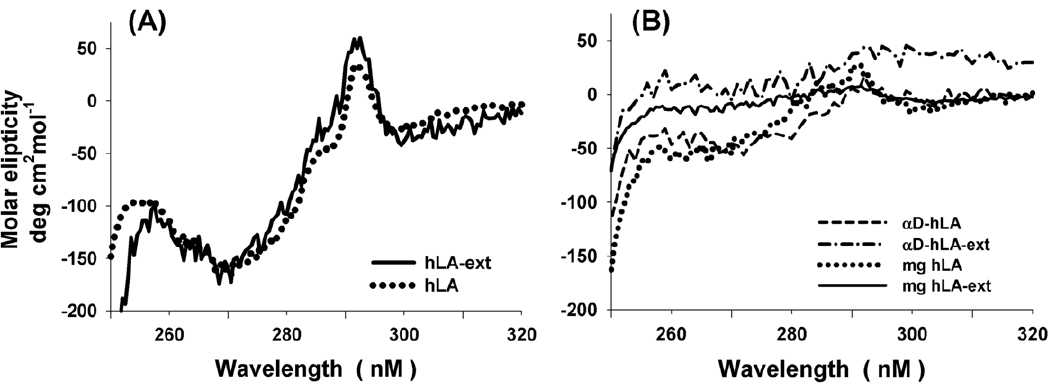
Figure 2. Tertiary structure studied with near UV CD spectra. (A) The near UV spectra of the native refolded hLA and hLA-ext proteins show positive and negative peaks indicating the CD bands arising from aromatic amino acids and suggest the presence of tertiary structure. When these proteins are treated with a chelating agent to remove Ca 2 + ion, these proteins acquire a molten globule state (B). Interestingly the a D-hLA and a D- hLA-ext show similar near UV CD spectra as molten globule hLA.